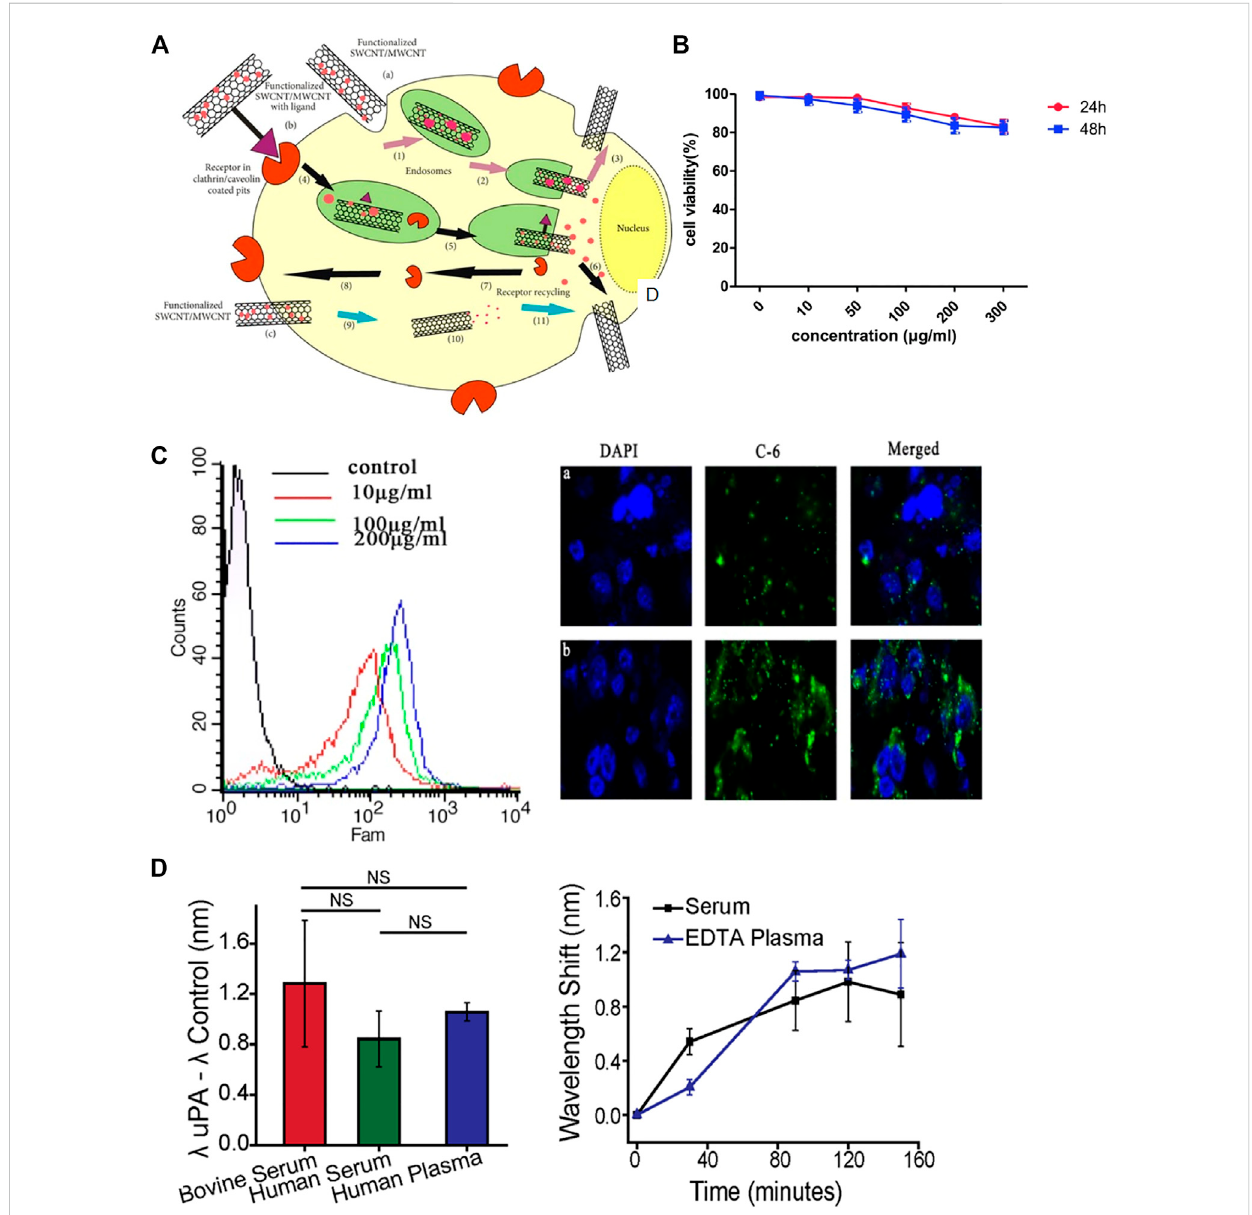
FIGURE 4 Biological applications of carbon nanotubes (CNTs). (A) CNTs penetrate into cells through various ways, including non-receptor-mediated endocytosis,receptor-mediatedendocytosisandendocytosis-independentmethods. (B) Flowcytometryandimmuno fl